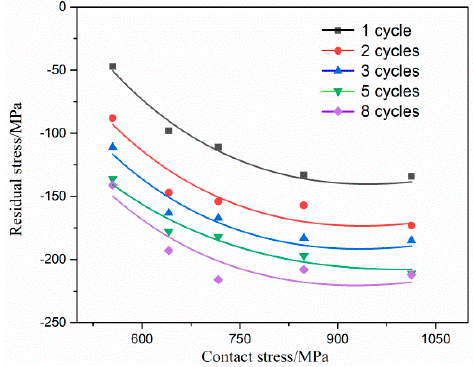
Figure 4. Influence of contact stress on residual stress.